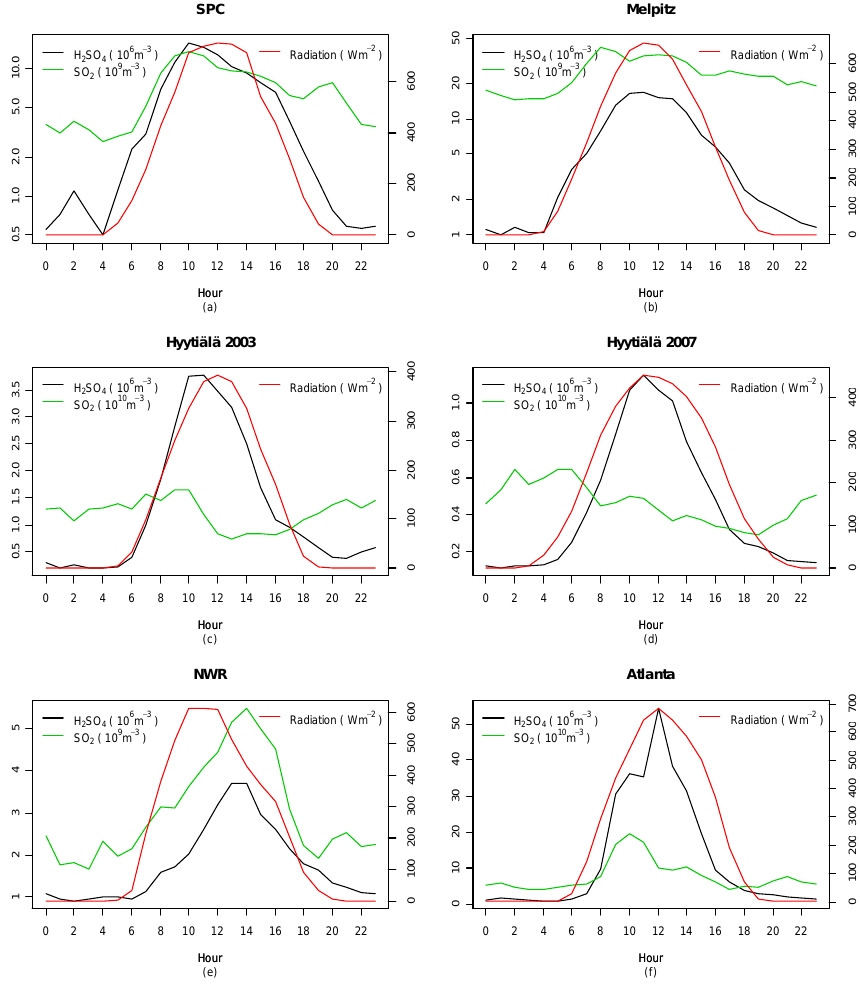
Fig. 2. Average diurnal variation of sulphuric acid, SO 2 (left axis) and Radiation (right axis) in local time.